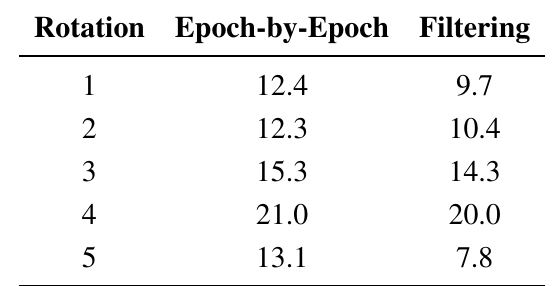
Table 8. 3D position RMSE (mm) for kinematic data (6-km baseline) processing with the proposed